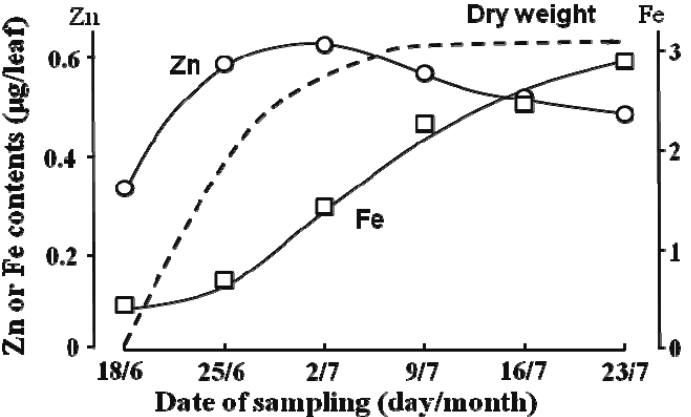
Figure 5. Changes in Zn and Fe amounts in the blade of the 10th leaf along with dry weight growth. (Adapted from Obata and Kitagishi [49]). The dry weight of the leaf was drawn arbitrarily as the dry weight at 23/7 had reached the maximum. ○ : change in the content of Zn; □ : change in the content of Fe. (Adapted from Obata and Kitagishi [49]). Xylem transfer cells found in vegetative nodes [56–58] and localized metal transporters (Table 2) may support the active xylem-to-phloem transfer of xylem sap Zn and Cd.